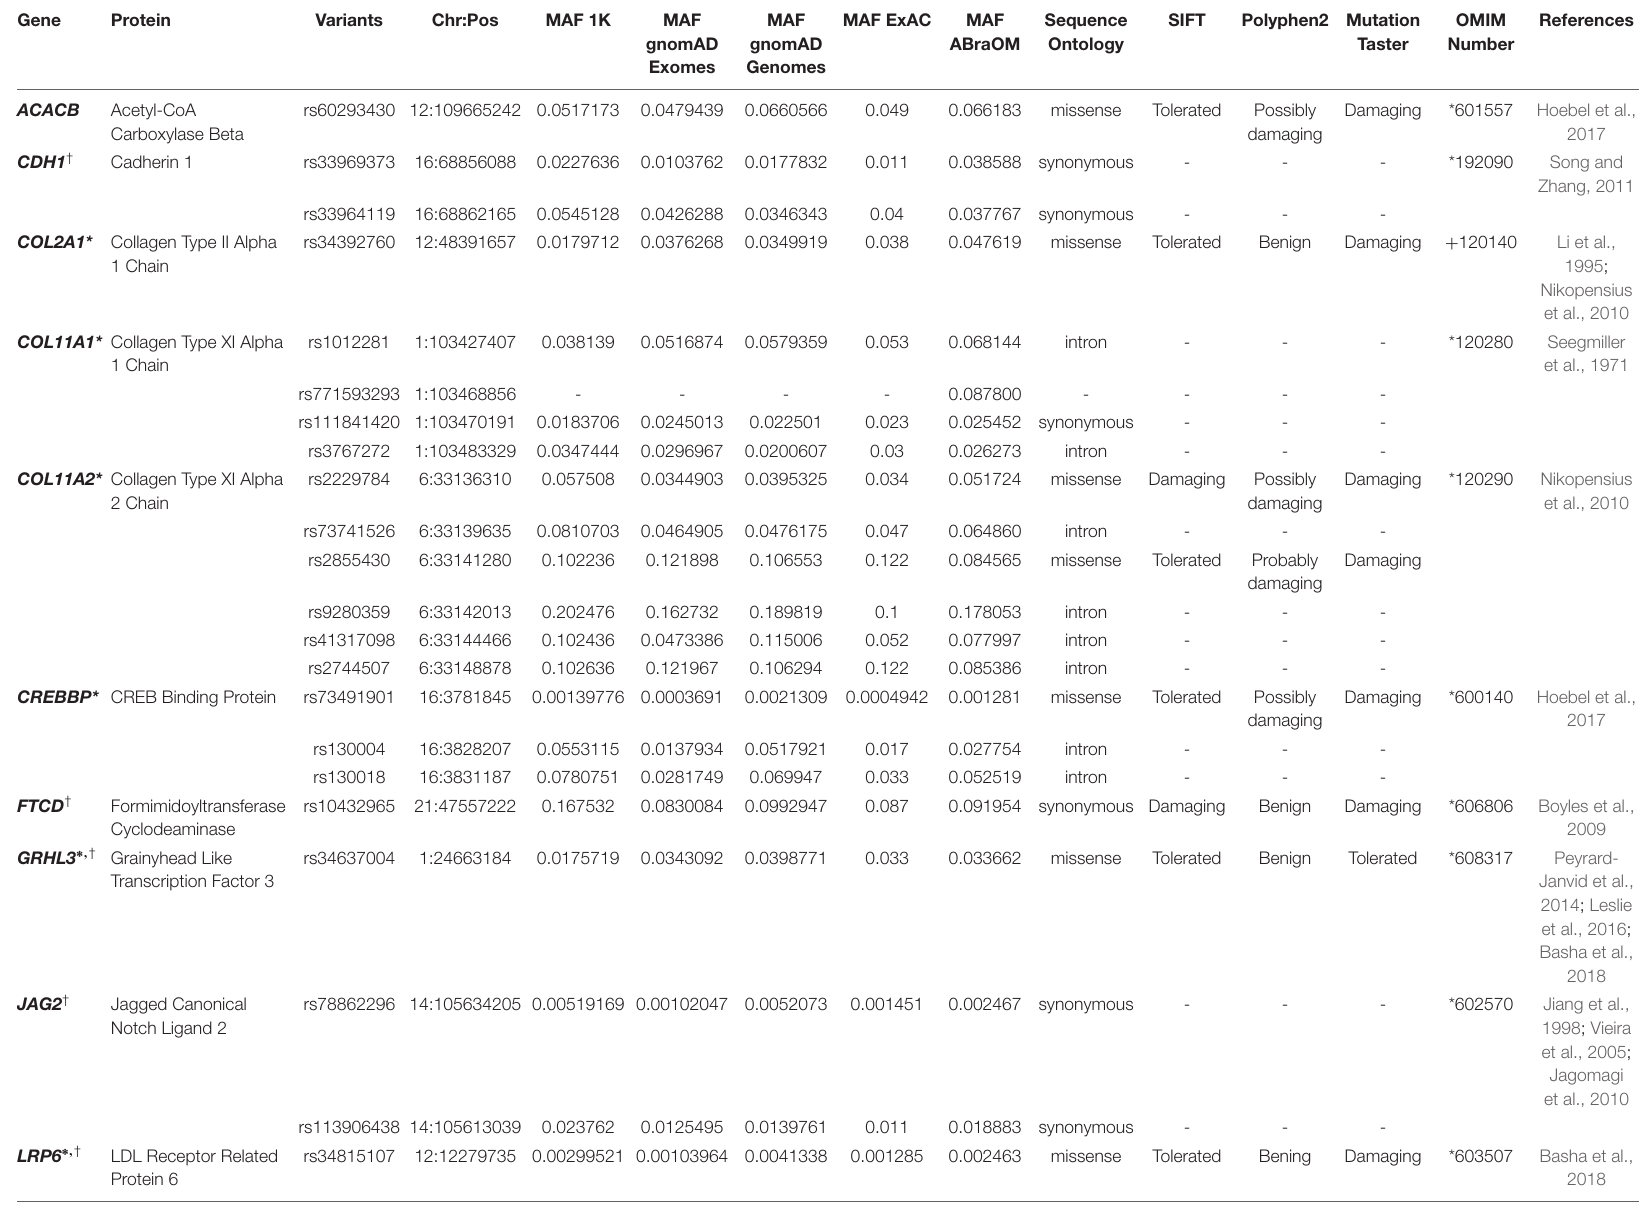
TABLE 1 | Novel variants in genes previously described in association with non-syndromic cleft palate only (NSCPO) found exclusively in the samples of patients with